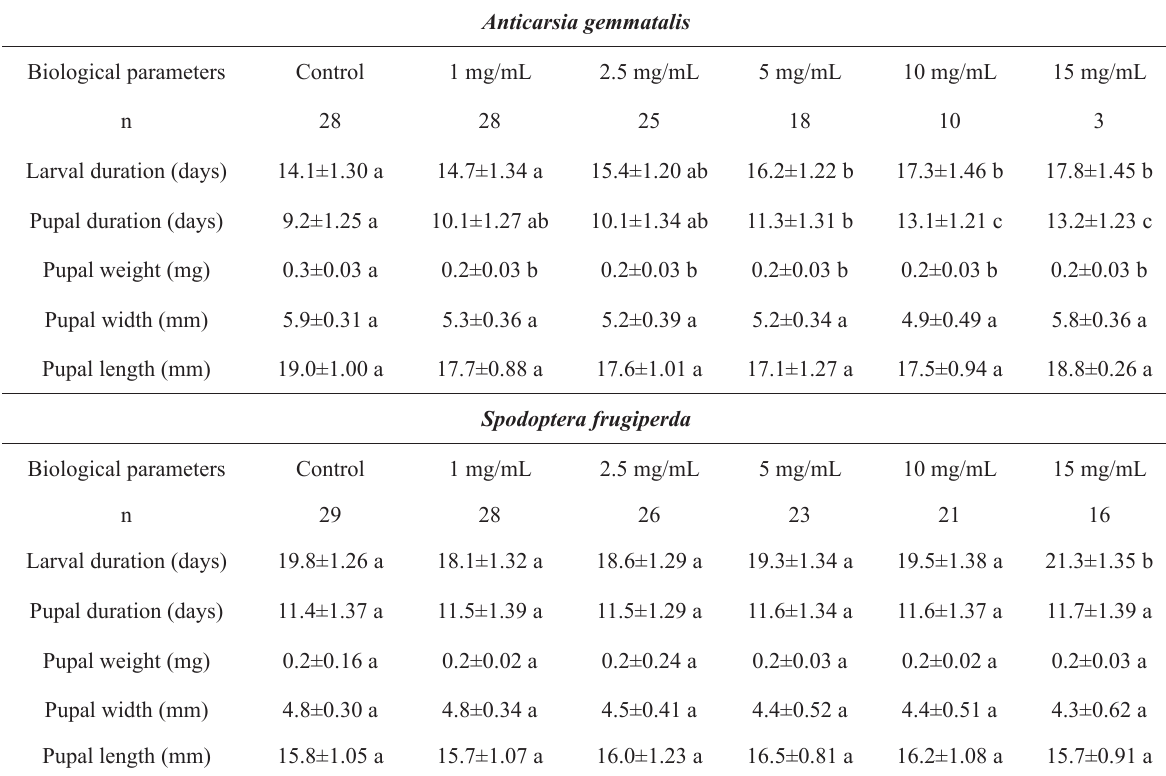
Biological parameters of Anticarsia gemmatalis and Spodoptera frugiperda fed artificial diet containing the ethyl acetate extract of Piper aduncum leaves